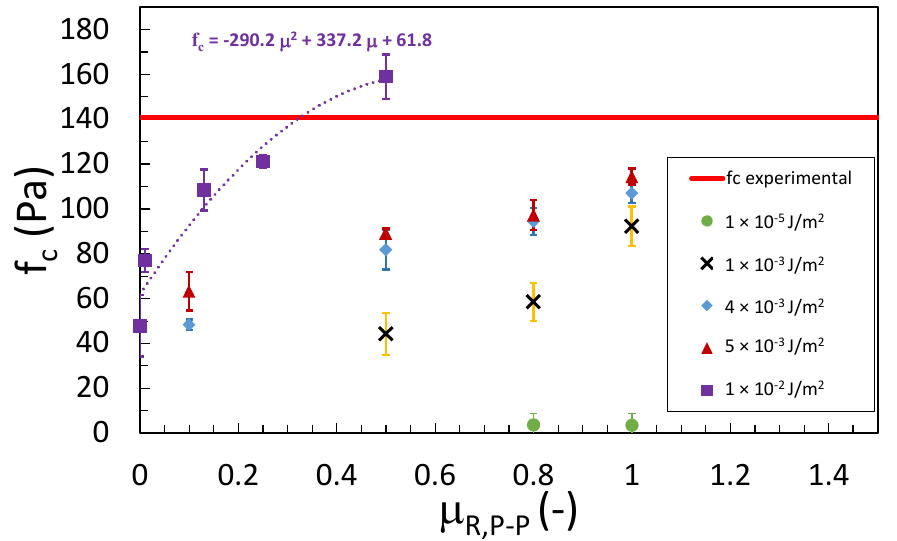
f c = -290.2 m 2 + 337.2 m + 61.8